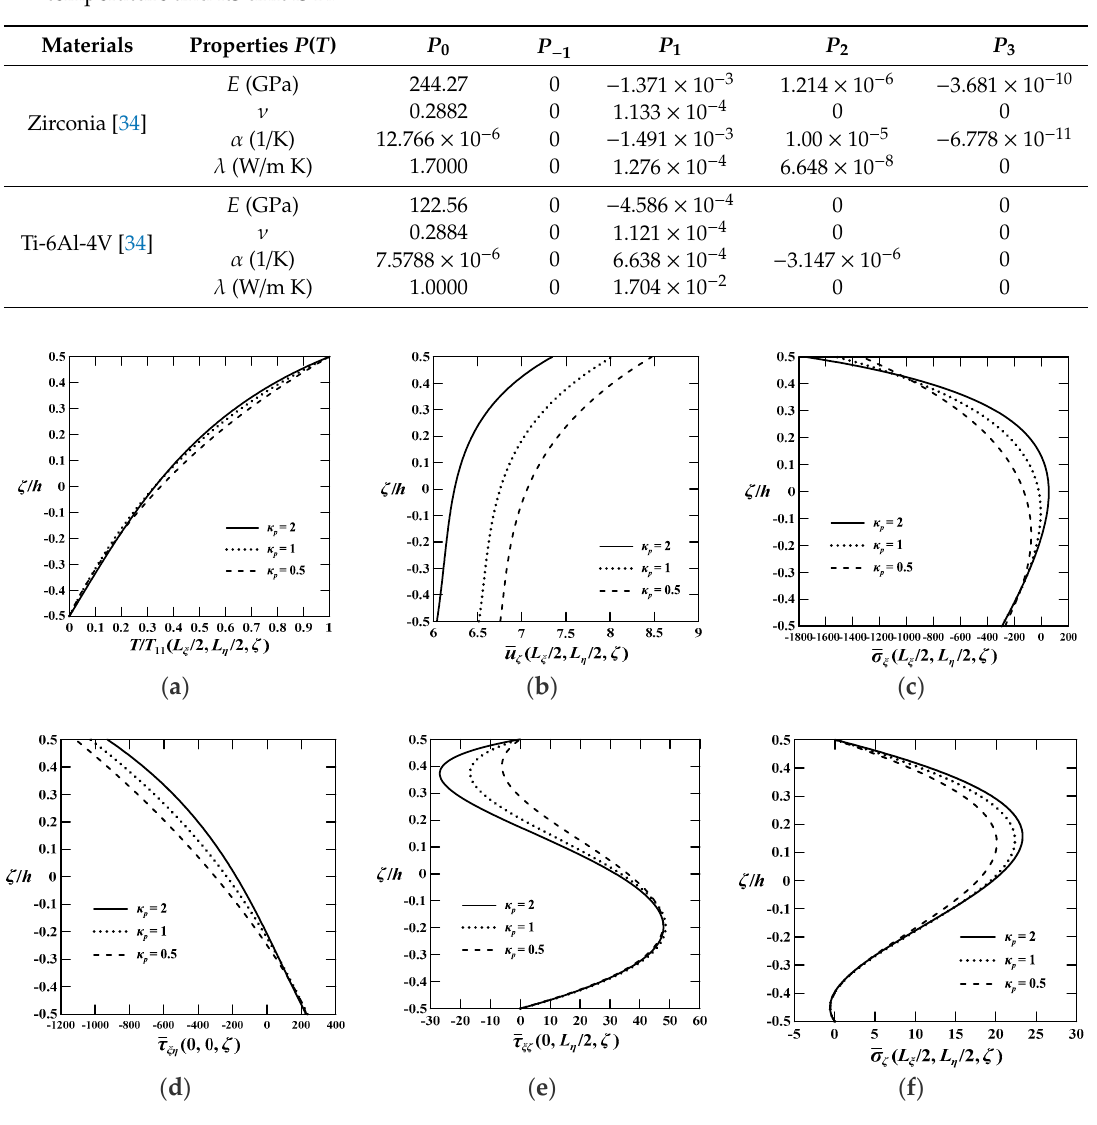
Figure 5. Through-thickness distributions of thermal and elastic field variables induced in an FGDC shell with different values of κ p . ( a ) Temperature; ( b ) Out-of-surface displacement; ( c ) In-surface normal stress; ( d ) In-surface shear stress; ( e ) Transverse shear stress; ( f ) Transverse normal stress. Table 3. Temperature-dependent material properties of metal and ceramic materials (Ti-6Al-4V and ( , and T ˆ denotes the current zirconia), in which temperature and its unit is K.